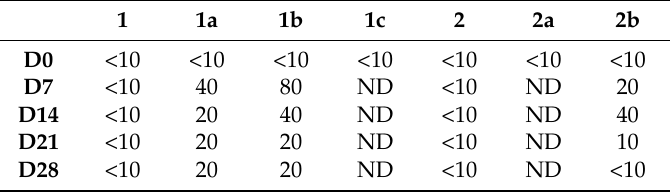
Table 1. Neutralizing antibody titers in goats experimentally infected or exposed by contact to MERS-CoV. Mother goats are indicated as 1 or 2, and their corresponded kids are indicated as 1a, 1b, 1c (Doe 1), 2a, or 2b (Doe 2). Titers represent dilutions of serum which neutralized ≥ 90% of input virus. ND = not done.